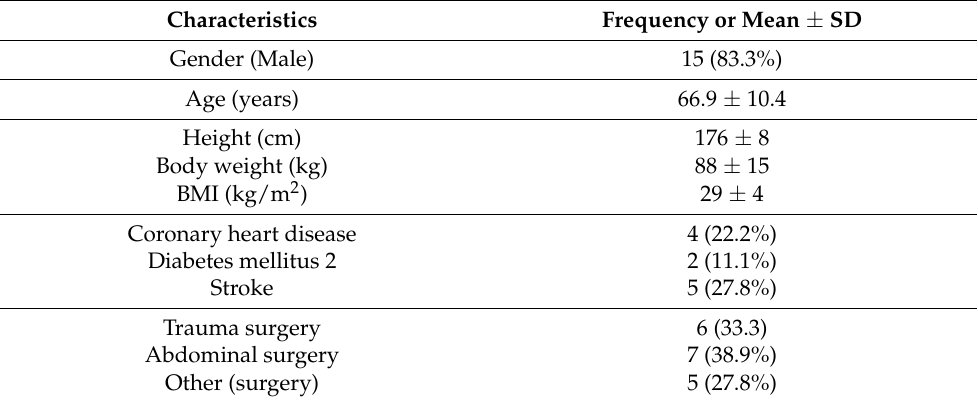
Table 1. Demographics.